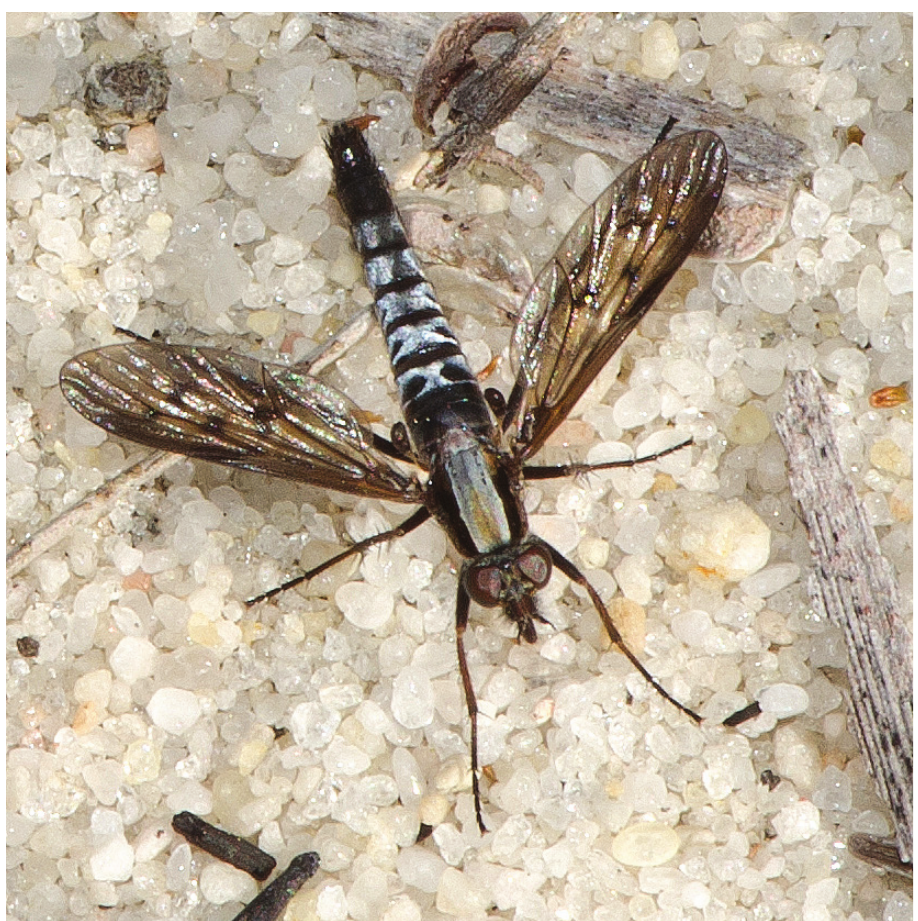
Figure 1. Adult male Sidarena hortorum sp. n.; Talbot Road Nature Reserve, Stratton, Perth, Western Australia. (Photo credit: Fred and Jean